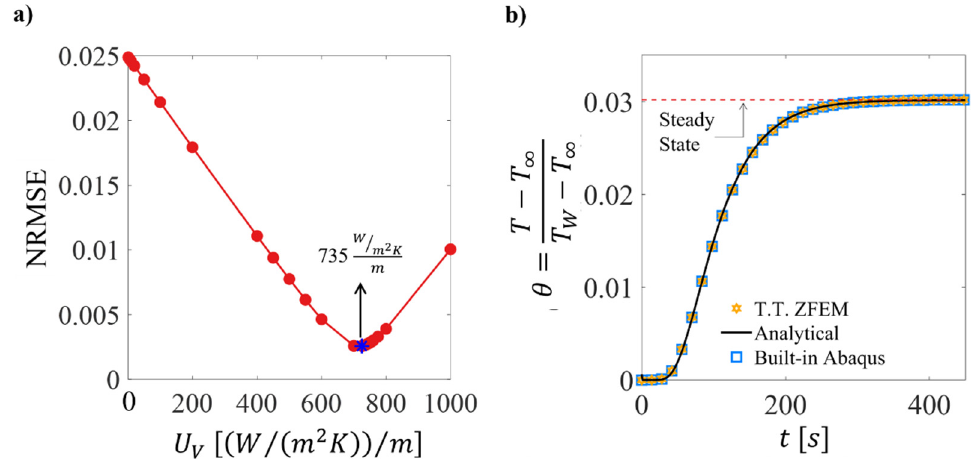
Figure 4. ( a ) Convergence analysis for the heat transfer coefficient per unit of thickness where the optimal value that minimizes the NRMSE is 735 W/ m 2 K /m. ( b ) The dimensionless temperature history of fin tip: solid black line, Equation (23), yellow star, the real part of Transient Thermal ZFEM solution, blue square, Abaqus built-in element solution, thin red dashed line, steady-state solution (Equation (24)). Table 1. Parameters involved in the transient thermal fin